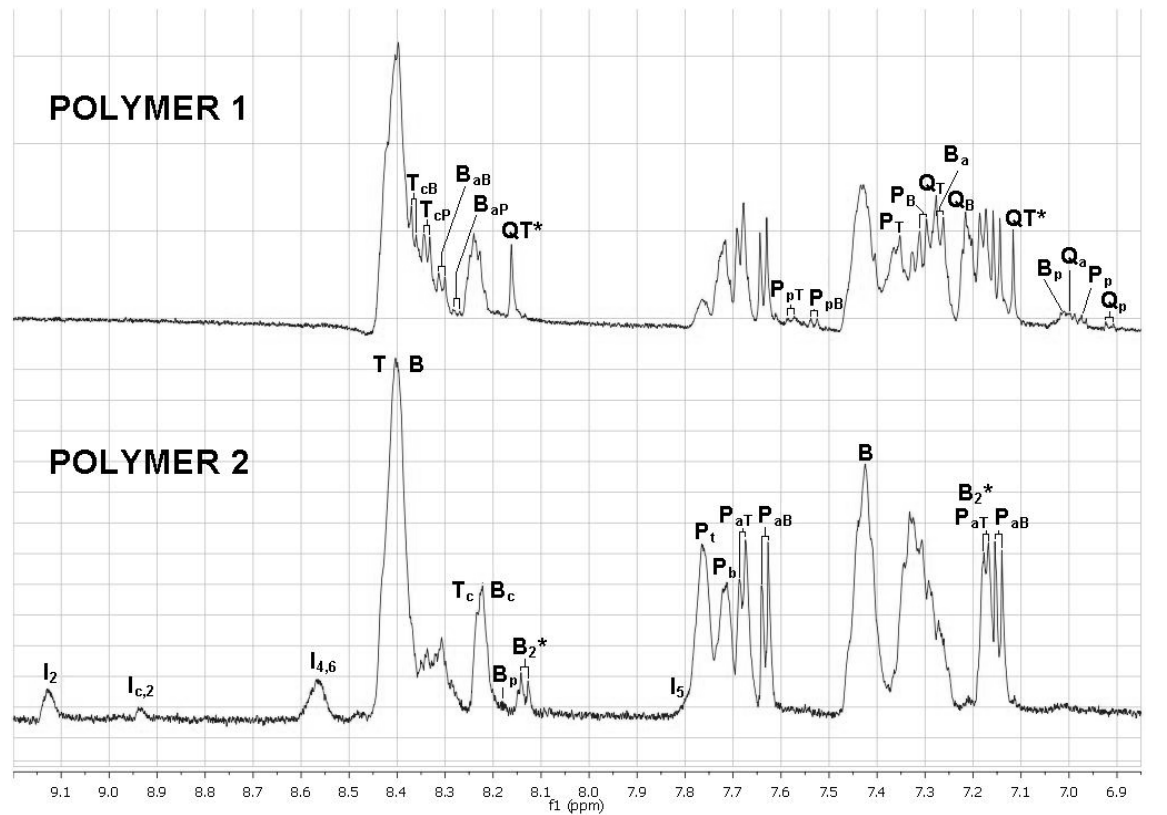
Figure 6. 1 H NMR spectra of HFIP extracts of polymers 1 (above) and 2